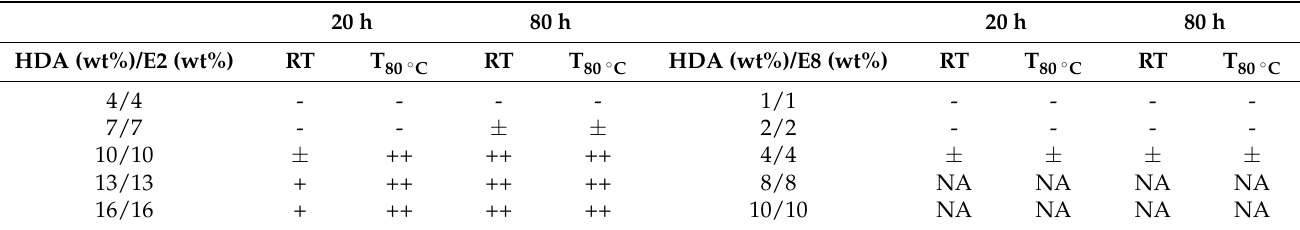
Table 3. Visual determination of epoxy-curing during interfacial polymerization (IP) for various concentrations of (i) HDA (i.e., 4–16 wt%) in water combined with E2 (i.e., 4–16 wt%) in Aliquat, and (ii) HDA (i.e., 1–10 wt%) in water combined with E8 (1–10 wt%) .1